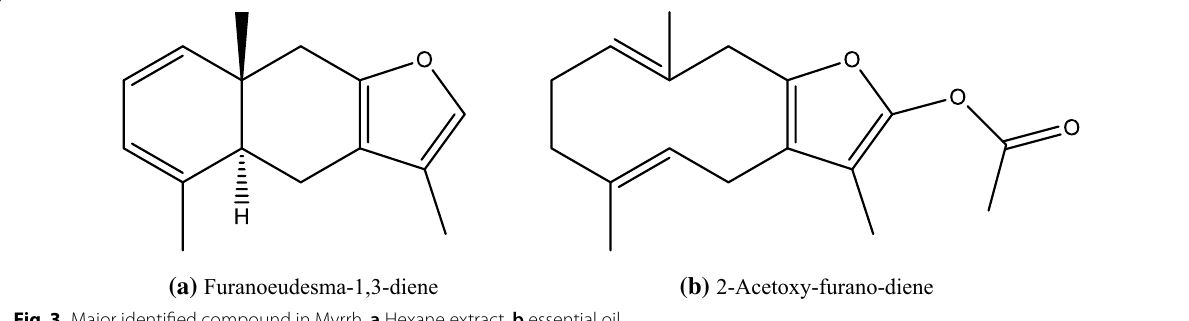
Fig. 3 Major identified compound in Myrrh. a Hexane extract, b essential